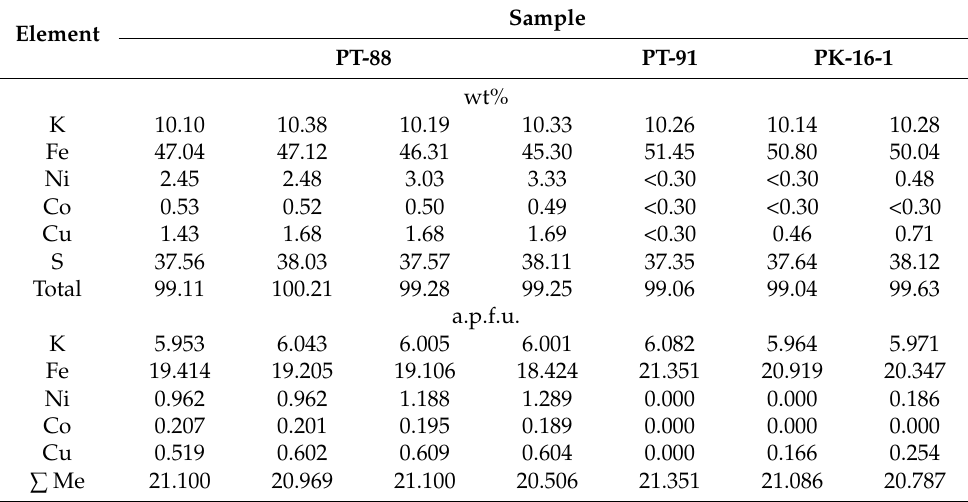
Table 11. Representative analyses of bartonite (K 6 Fe 21 S 27 ) from Tly-Wo marbles (Zone 4) of the Kochumdek contact aureole (SEM-EDS